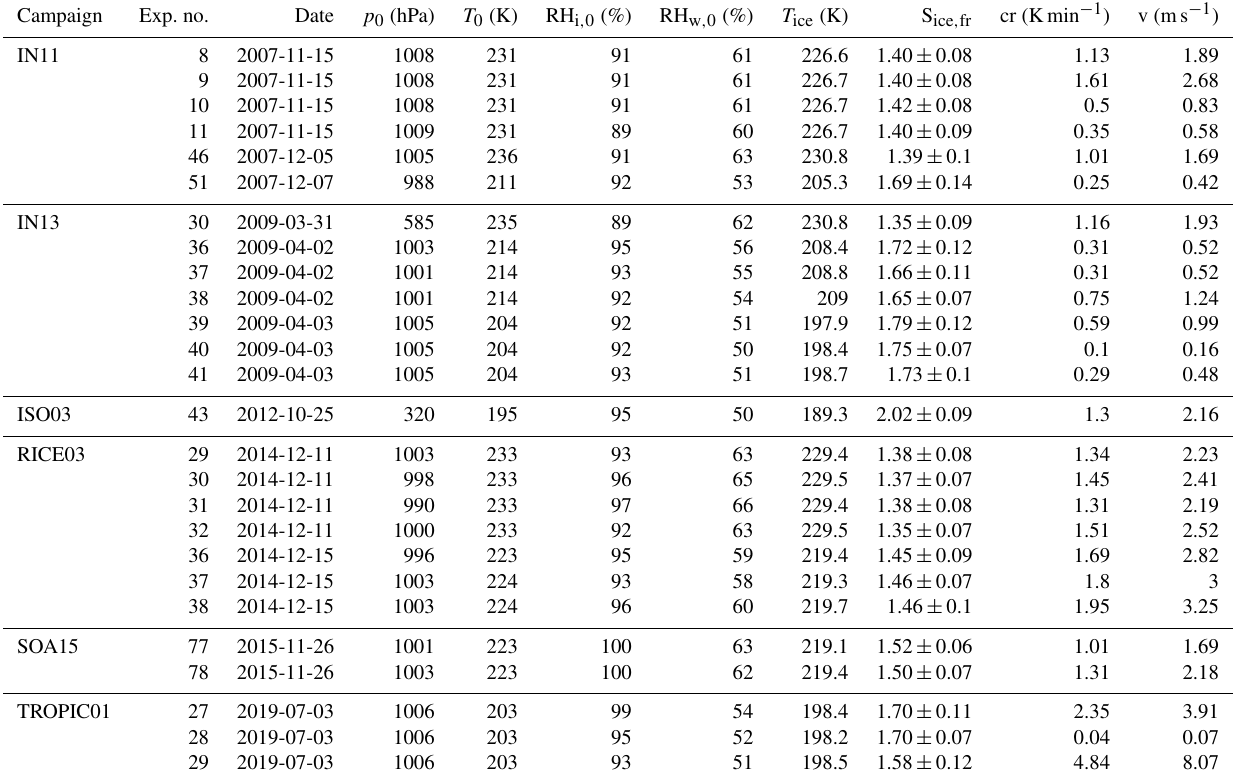
Table B2. Summary of H 2 SO 4 / H 2 O AIDA experiments part II. The considered experiments are listed together with the corresponding campaign, the experiment number, the date of the experiment, the starting pressure p 0 , the starting temperature T 0 , the starting relative humidity with respect to ice RH i , 0 and liquid water RH w , 0 , the freezing onset temperature T ice , the ice saturation ratio at freezing onset S ice , fr , the cooling rate cr, and the corresponding vertical velocity v at the freezing onset. Campaign Exp.